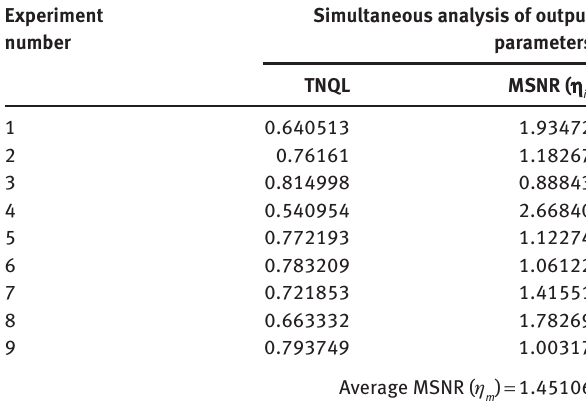
Table 15: Total normalized quality loss (TNQL) and multi S/N ratios (MSNR) for output parameters in the machining of 2024 alloy.